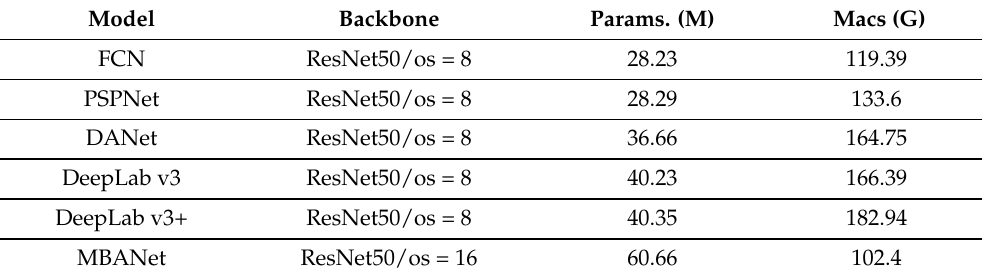
Table 14. Computational complexity of different